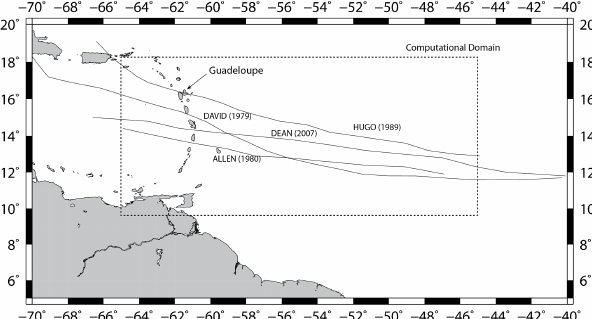
Figure 1. Computational domain and tracks of a few recent major storms that have affected the French West Indies.